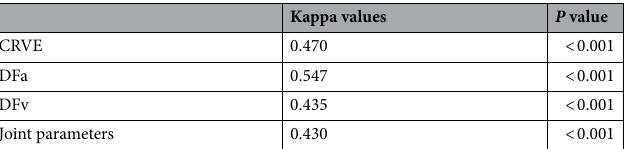
Table 4. Kappa analysis of retinal vessel geometry parameters and VPT in DPN. VPT Vibration perception threshold, DPN diabetic peripheral neuropathy, CRVE Central retinal vein equivalent, DFa Fractal dimension arterioles, DFv Fractal dimension veins.